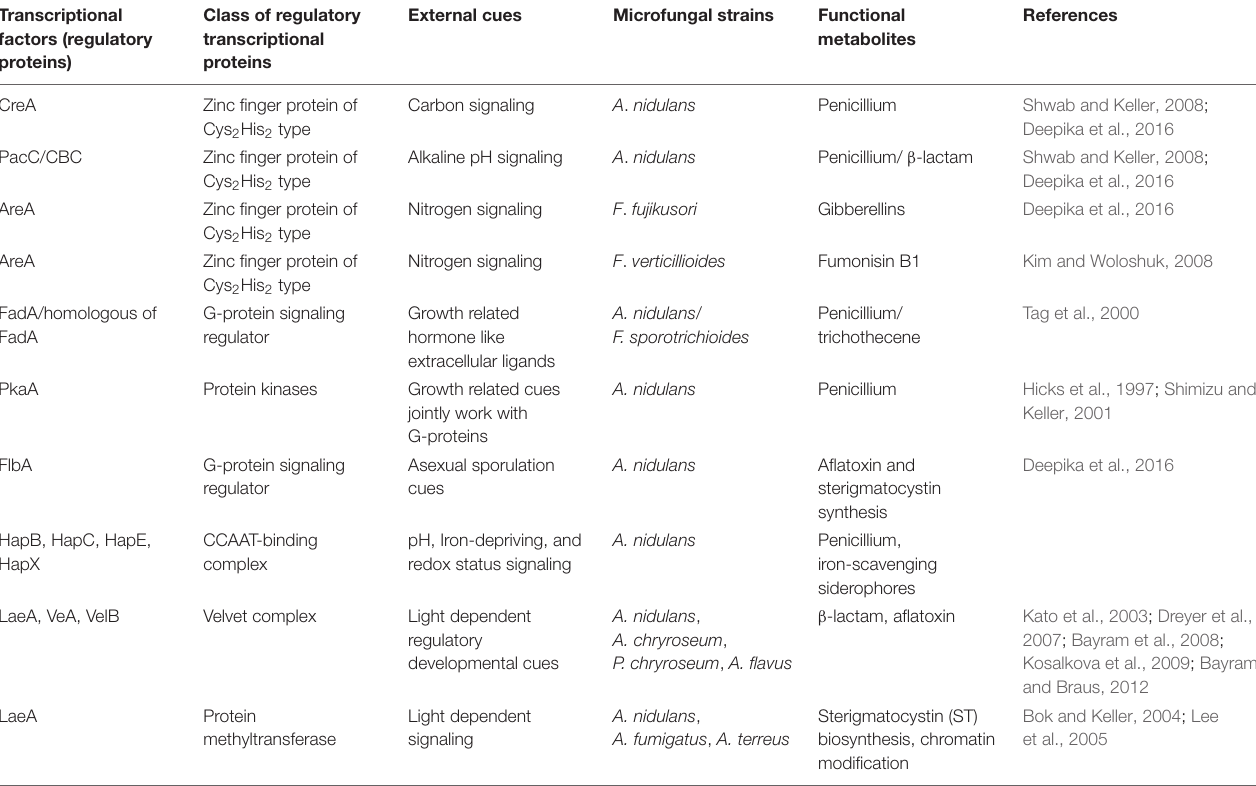
TABLE 2 | Broad domain transcription factors (BDTFs)/global transcription